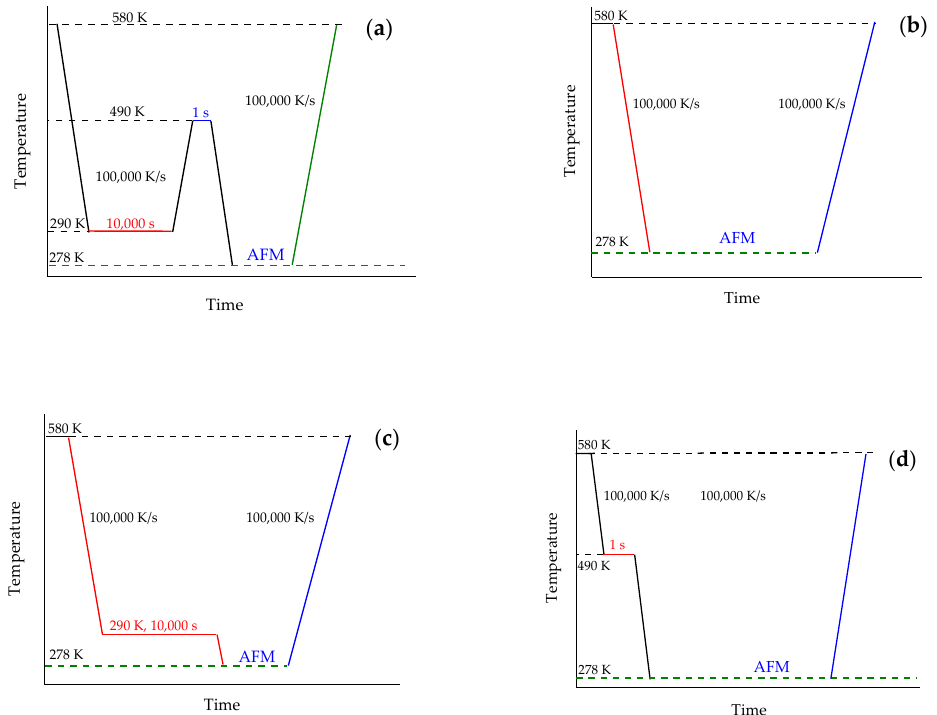
Figure 14. Temperature profile for nucleation studies of poly(butylene terephthalate) (PBT). All cooling and heating scans were performed at 100,000 K / s. ( a )—Tammann’s two-stage nuclei development method. PBT was first cooled to the nucleation temperature of 290 K, and nucleated for di ff erent times. Then the sample was heated to the growth temperature of 490 K and crystal growth from existing nuclei was allowed for 1 s. The corresponding images were taken at ambient temperature. After each nucleation experiment, the sample was heated to 580 K for observation of the crystallinity by the melting enthalpy. ( b )—quenching to ambient temperature of 278 K and imaging of the fully amorphous sample; ( c )—quenching to the nucleation temperature of 290 K, annealing for 10,000 s and taking an image at 278 K; ( d )—melt-crystallization at 490 K for 1 s, followed by imaging at ambient temperature.